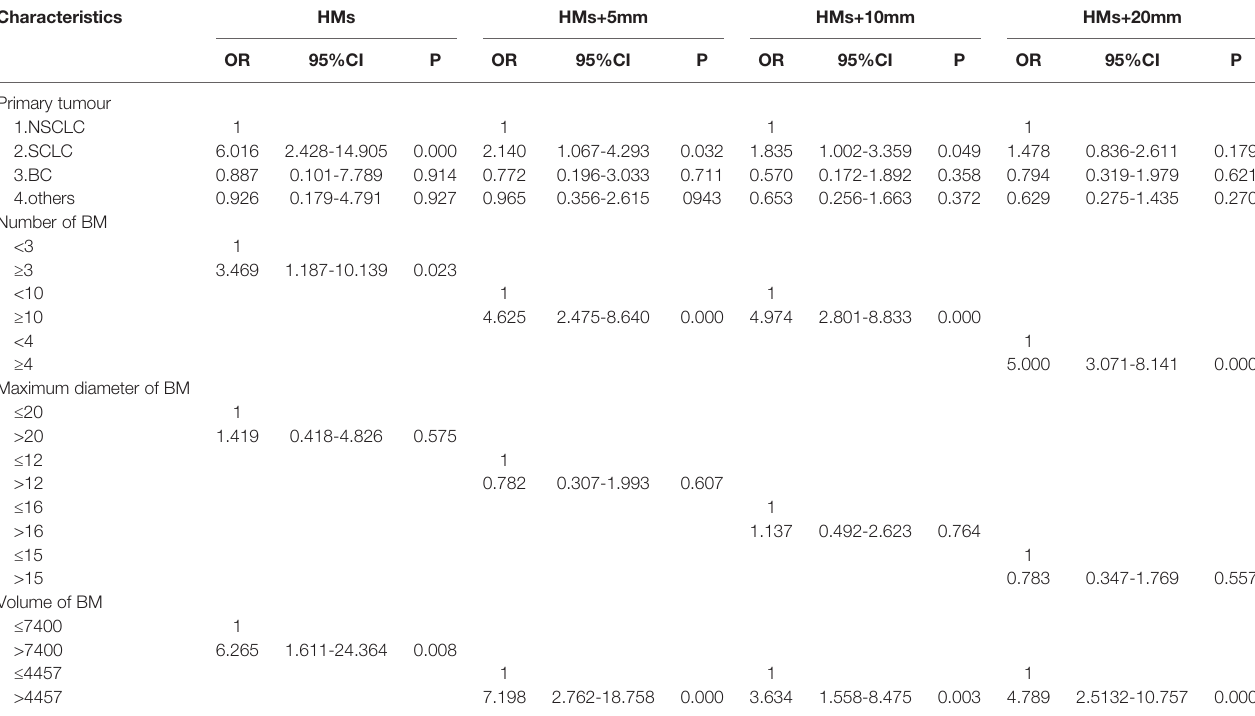
TABLE 5 | Multivariate analysis of the risk factors of hippocampal involvement with different margin de fi nition.